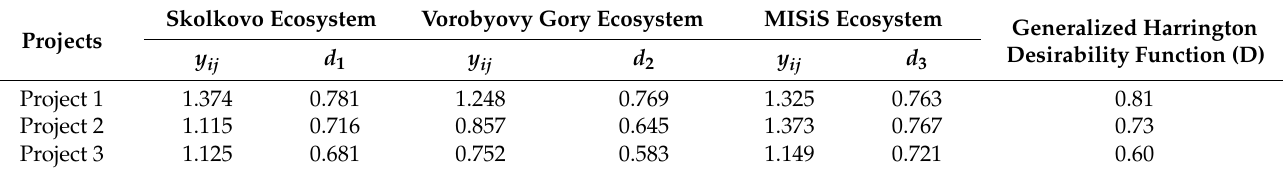
Table 4. Interpretation of standard marks on the Harrington scale for